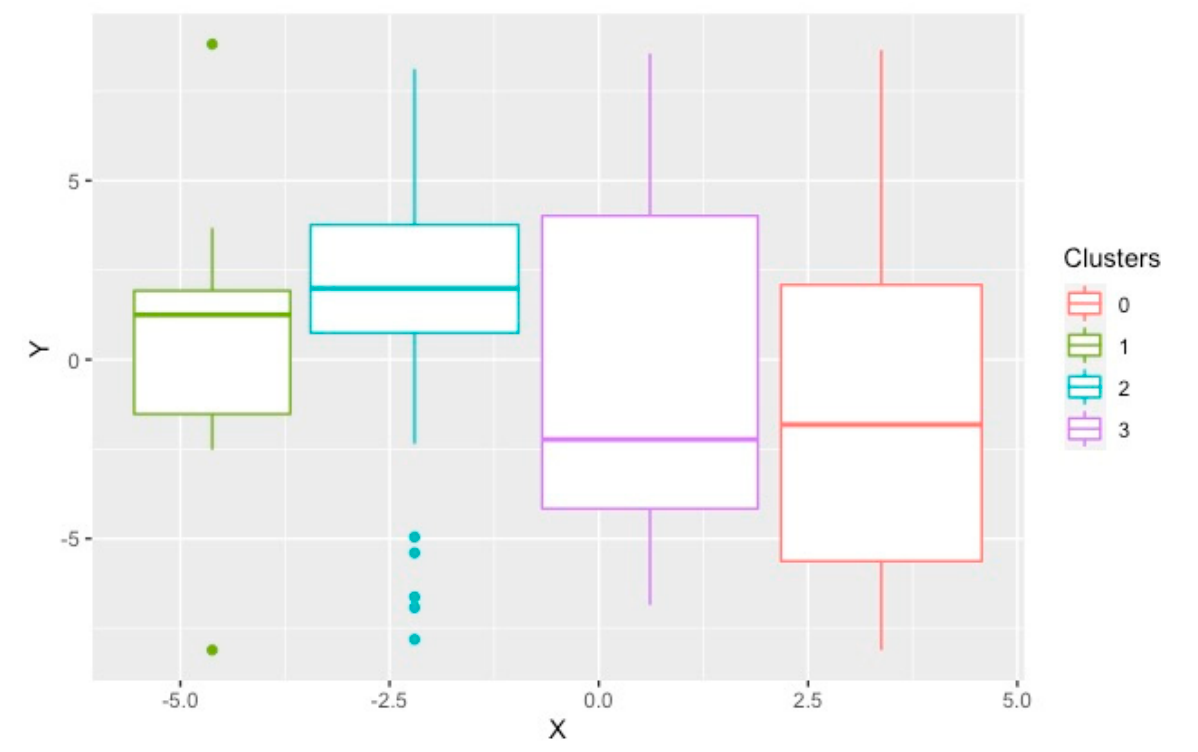
Figure 2. T–distributed stochastic neighborhood embedding used to show the local structures of the clusters produced by K–prototype on a two-dimensional plot. Each point represents one study subject. Table 2. Summary of clusters using the K-prototype method ( n = 196).